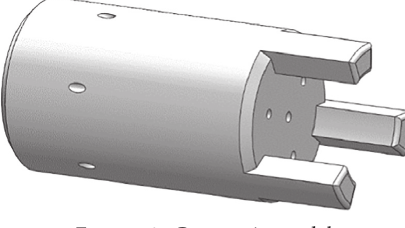
Figure 2: Geometric model.